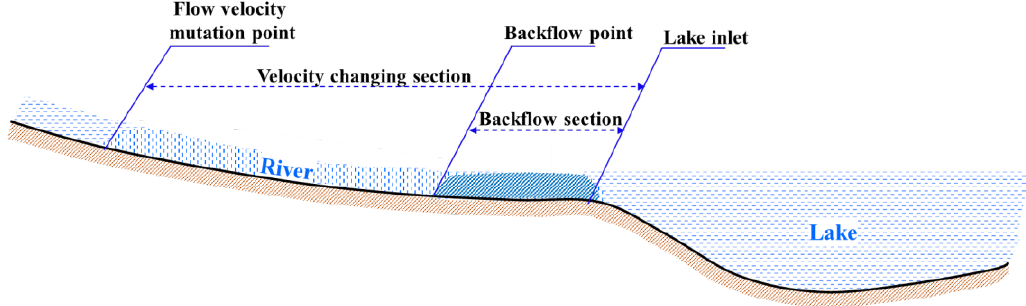
Figure 3. Components of the upper boundary of the river – lake transition zone.